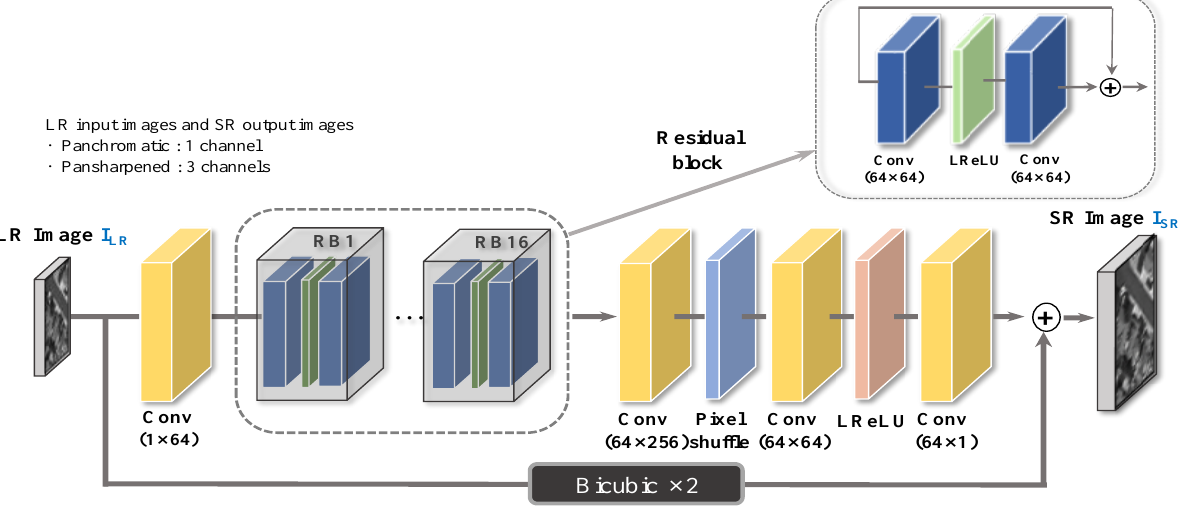
Figure 4. Architecture of the proposed SR network for